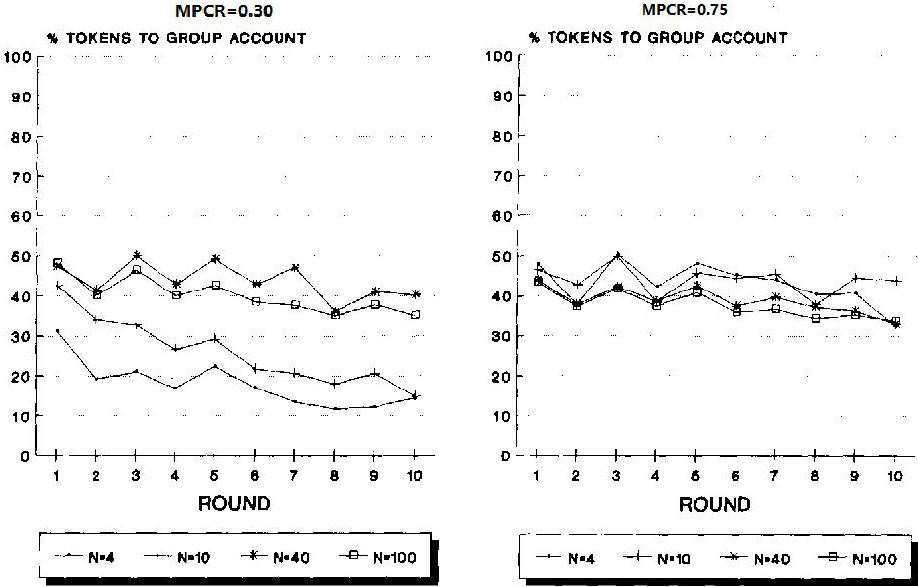
Figure 4. Group size comparison for high (0.75) and low (0.30) MPCR.